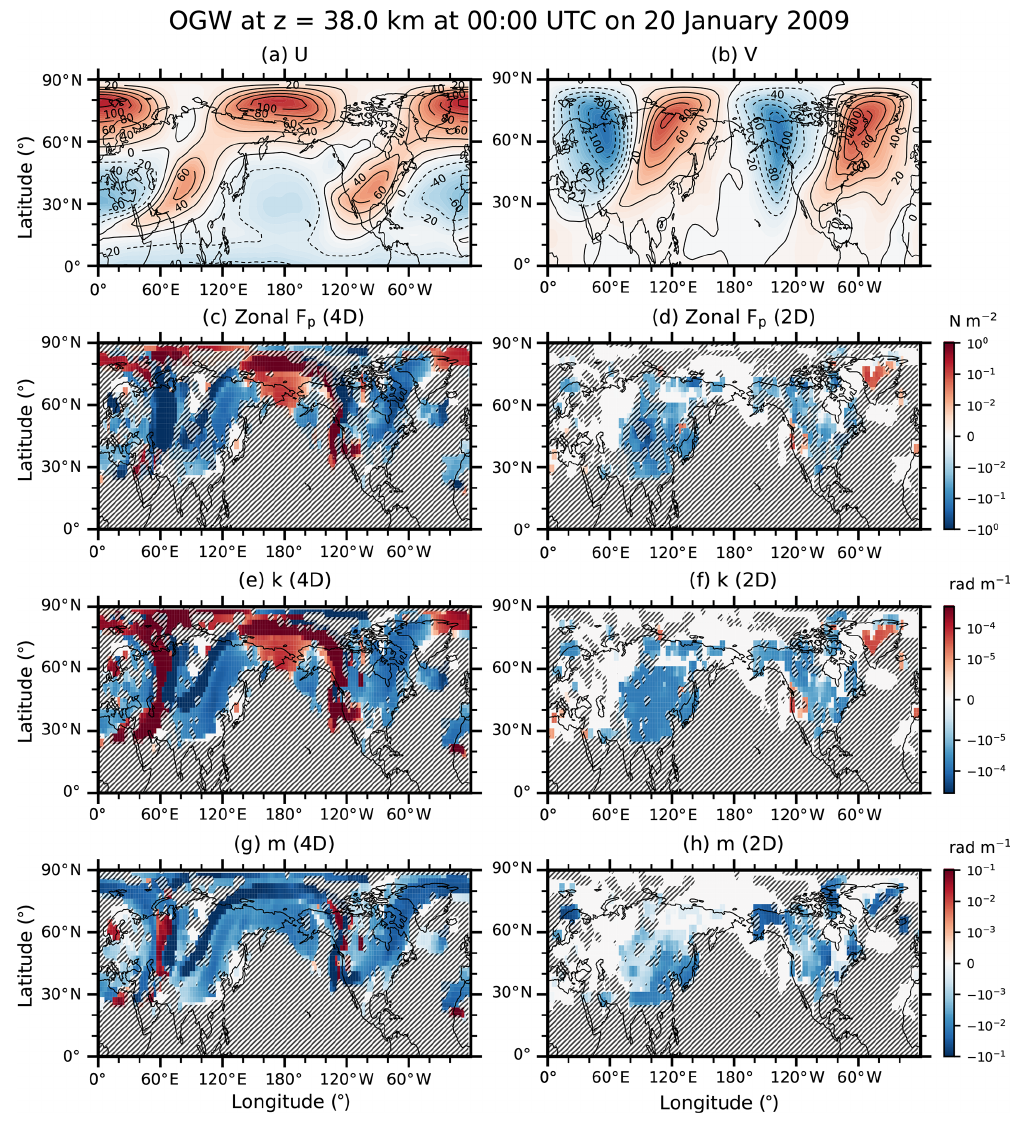
Figure 9. Longitude–latitude cross sections of (a) zonal wind ( U ), (b) meridional wind ( V ), and ensemble means of (c–d) zonal pseudomo- mentum fluxes ( F p ), (e–f) zonal wave numbers, and (g–h) vertical wave numbers for OGW at z = 38km in the 4D and 2D experiments at 00:00UTC on 20 January 2009. OGW F p is multiplied by the efficiency factor (0.125). Contour interval for zonal and meridional winds is 20ms − 1 , and negative values are plotted in broken lines. Hatched areas indicate regions where the paired and two-tailed t test for the 4D and 2D experiments gives p values larger than 0.05 (i.e., no statistical significance at the level of